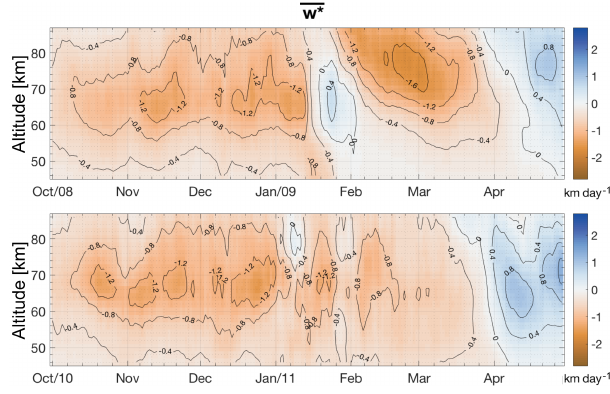
Figure 12. The north polar average (60–90 ◦ N) TEM vertical wind, w ∗ , for the winters of 2008/2009, and 2010/2011. The values are calculated using daily averaged output from